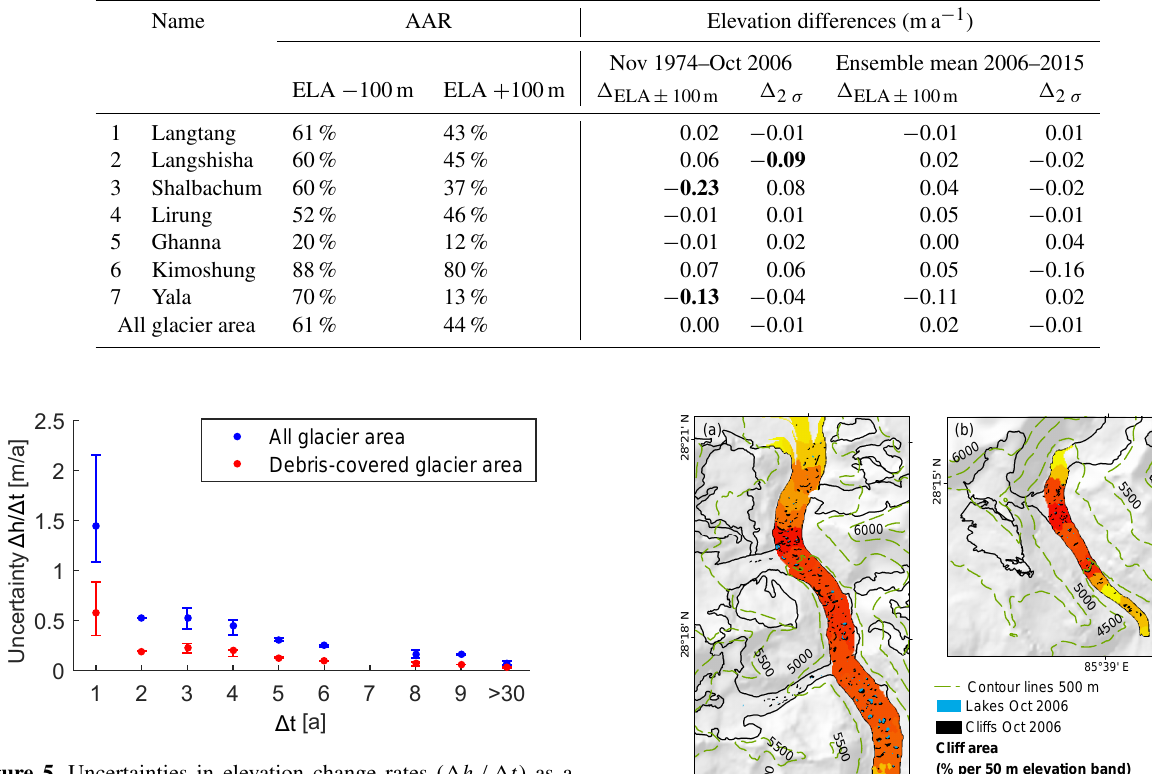
Figure 5. Uncertainties in elevation change rates ( (cid:49)h/(cid:49)t ) as a function of the time interval between DEMs ( (cid:49)t ). Median results of all available 28 (cid:49)h/(cid:49)t maps. Error bars extend to the most extreme data points.